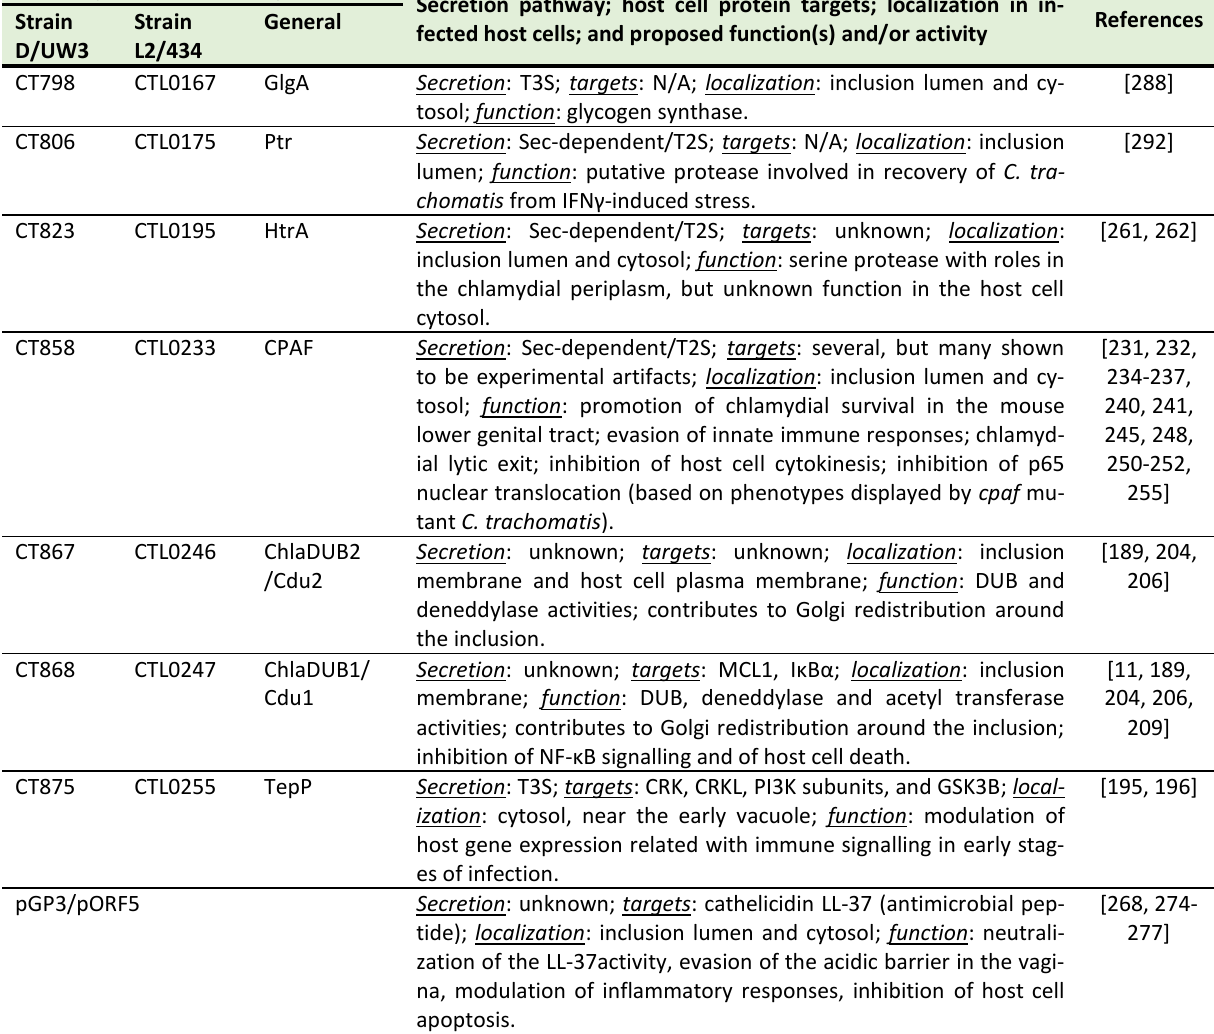
TABLE 2: C. trachomatis non-Inc proteins secreted into the host cell cytoplasm, inclusion membrane, or inclusion lumen a (continued). Protein